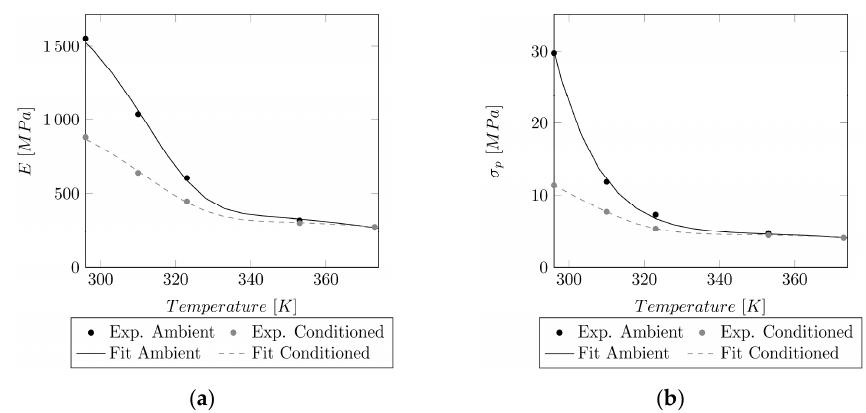
The results of the fit are depicted in Figure 4.